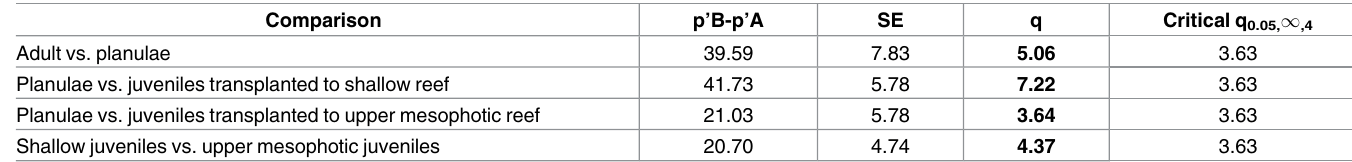
Table 2. Tukey-type multiple comparison of proportions of Symbiodinium phylotype frequencies in P . astreoides life stages. Comparison p’B-p’A SE q Adult vs. planulae Planulae vs. juveniles transplanted to shallow reef Planulae vs. juveniles transplanted to upper mesophotic reef Shallow juveniles vs. upper mesophotic